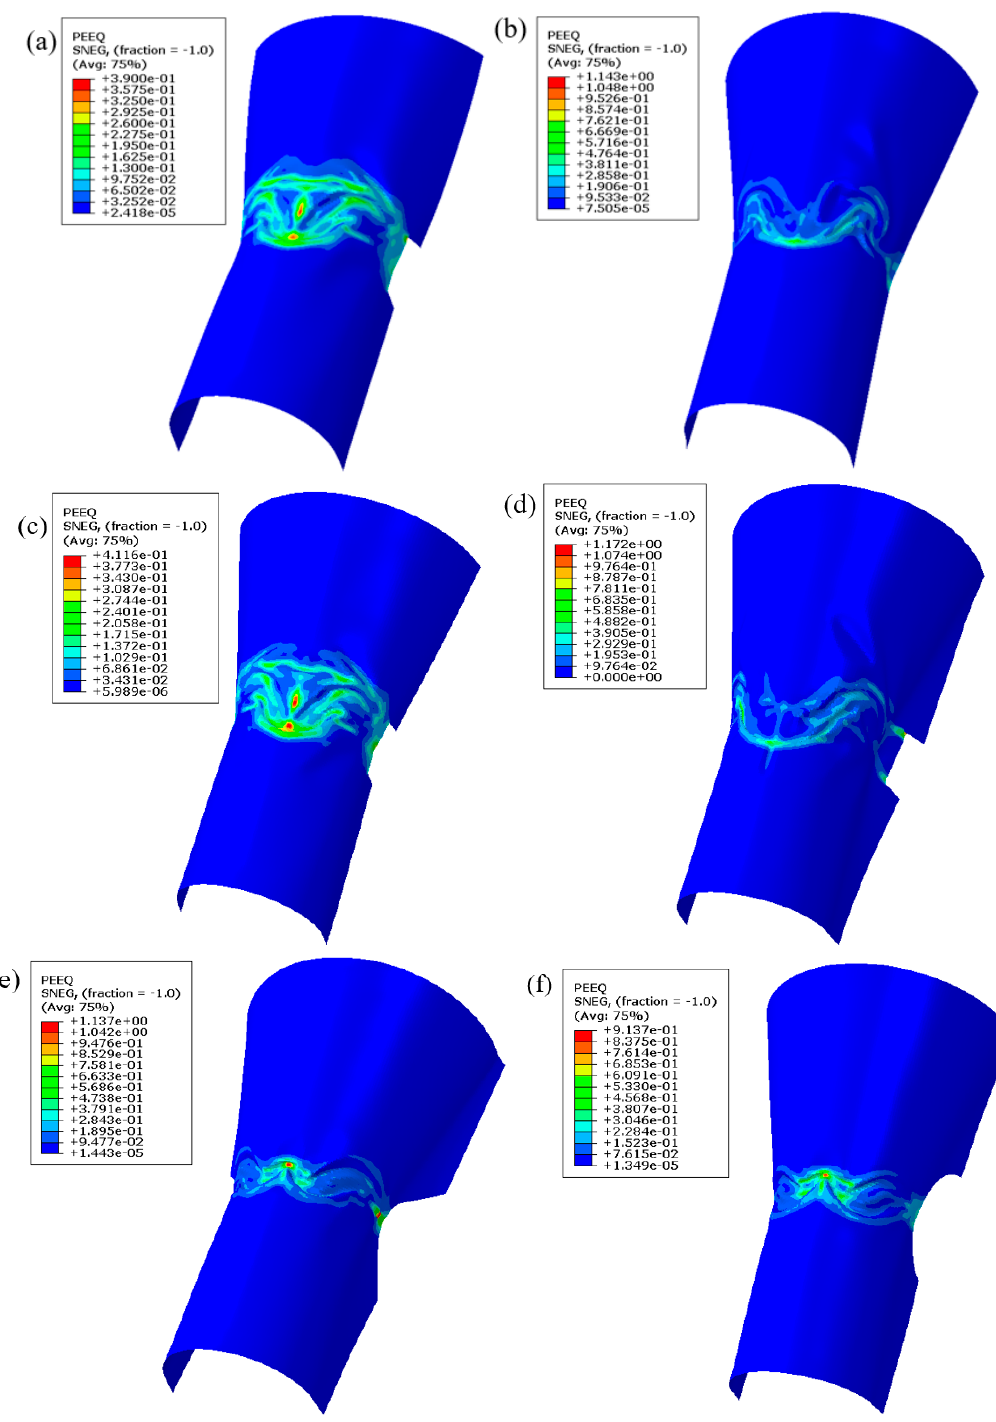
Figure 7. Distribution of equivalent strain at 850 °C–0.001 s − 1 using different initial sheet blanks: ( a ) Blank A; ( b ) Blank B; ( c ) Blank C; ( d ) Blank D; ( e ) Blank E; ( f ) Blank F.